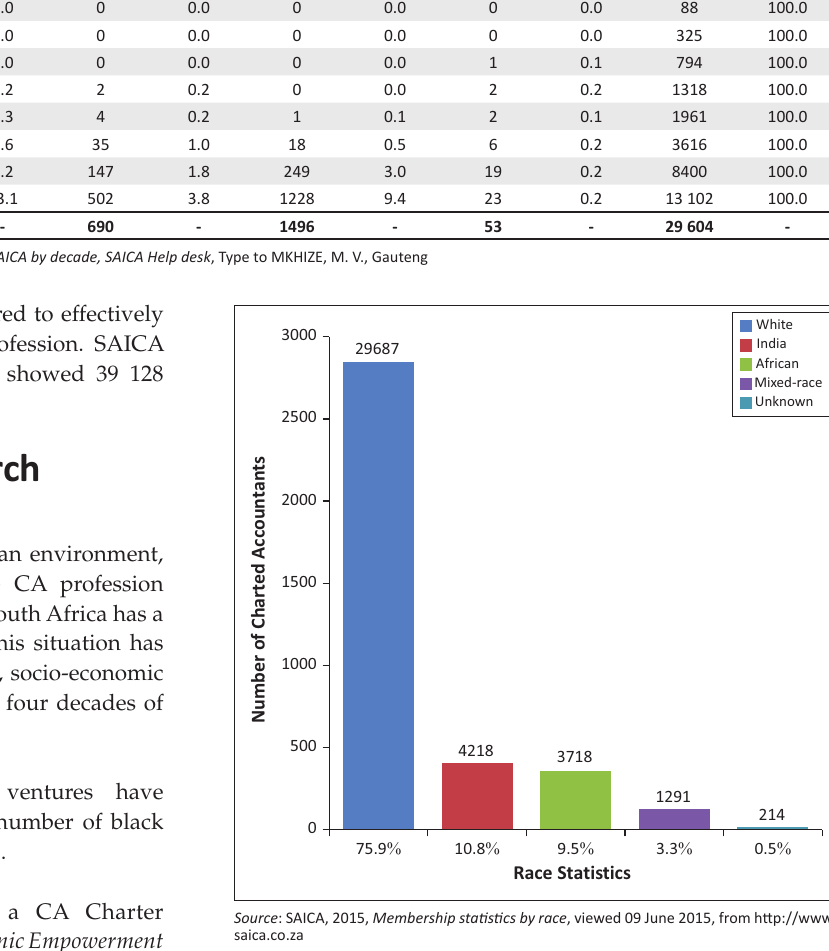
FIGURE 1: Demographics of South African Institute of Chartered Accountants membership as at 30 June 2015.